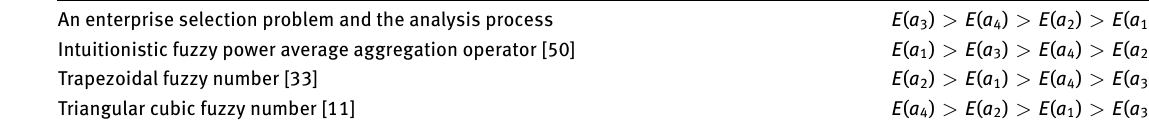
Table 15: Comparison Analysis with Existing